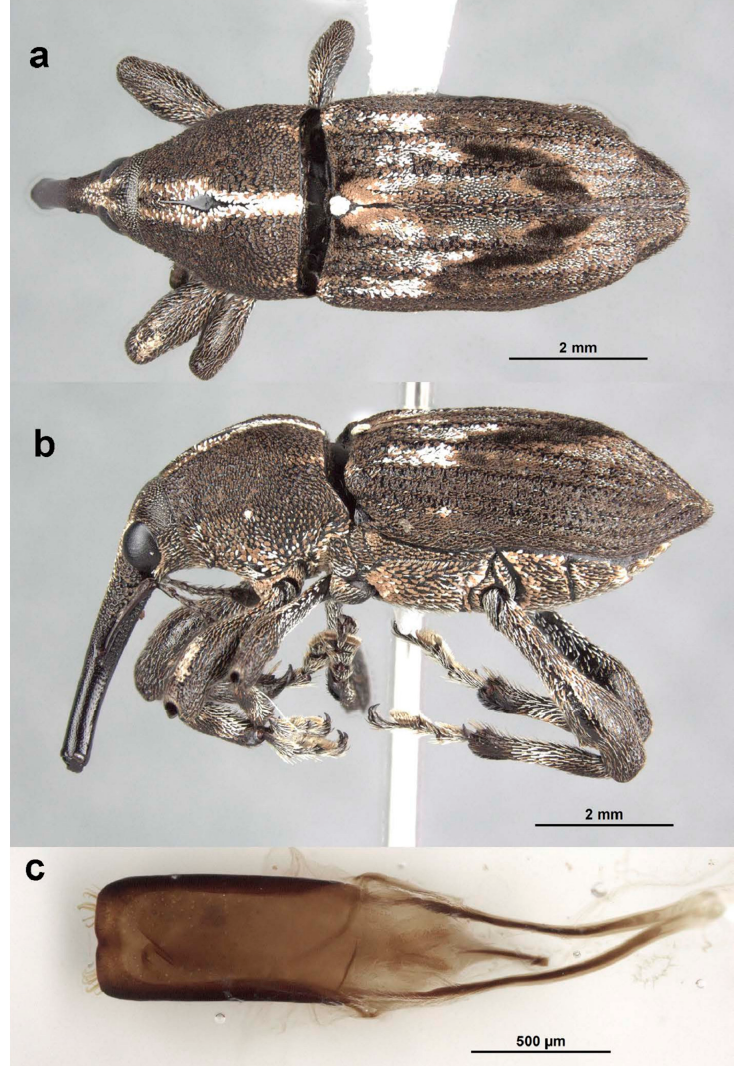
Figure 8. Ilacuris papuana : ( a ) habitus of female, dorsal aspect; ( b ) habitus of female, lateral aspect; ( c ) aedeagus, dorsal aspect.